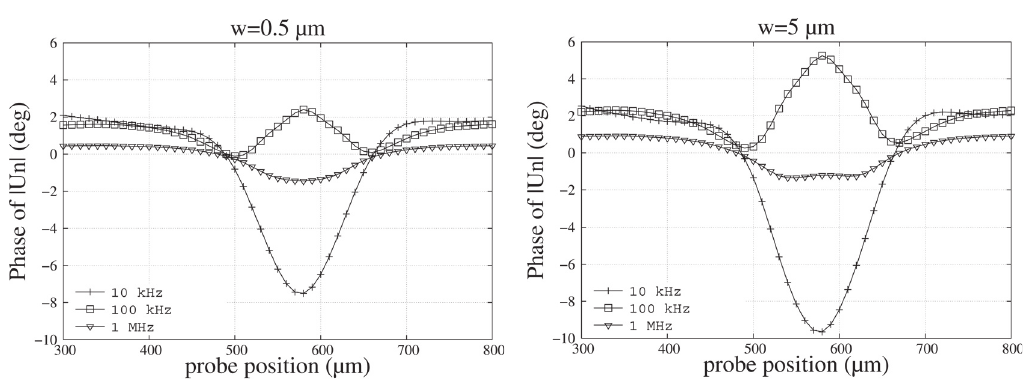
Fig. 4. Thermoelastic displacement phase